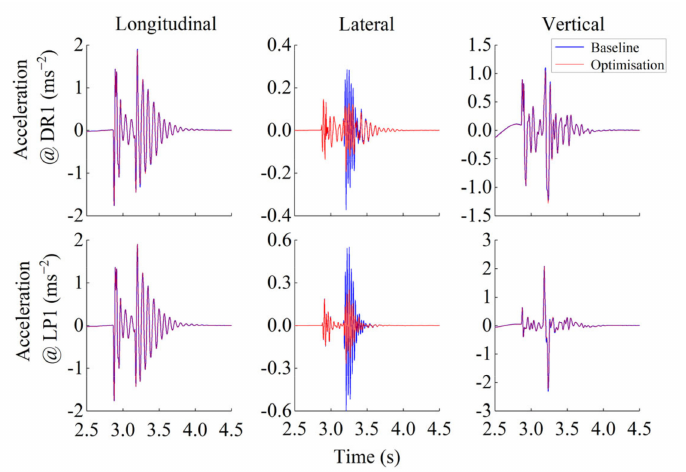
Figure 8. Comparison of accelerations at seat rails between the baseline and optimized